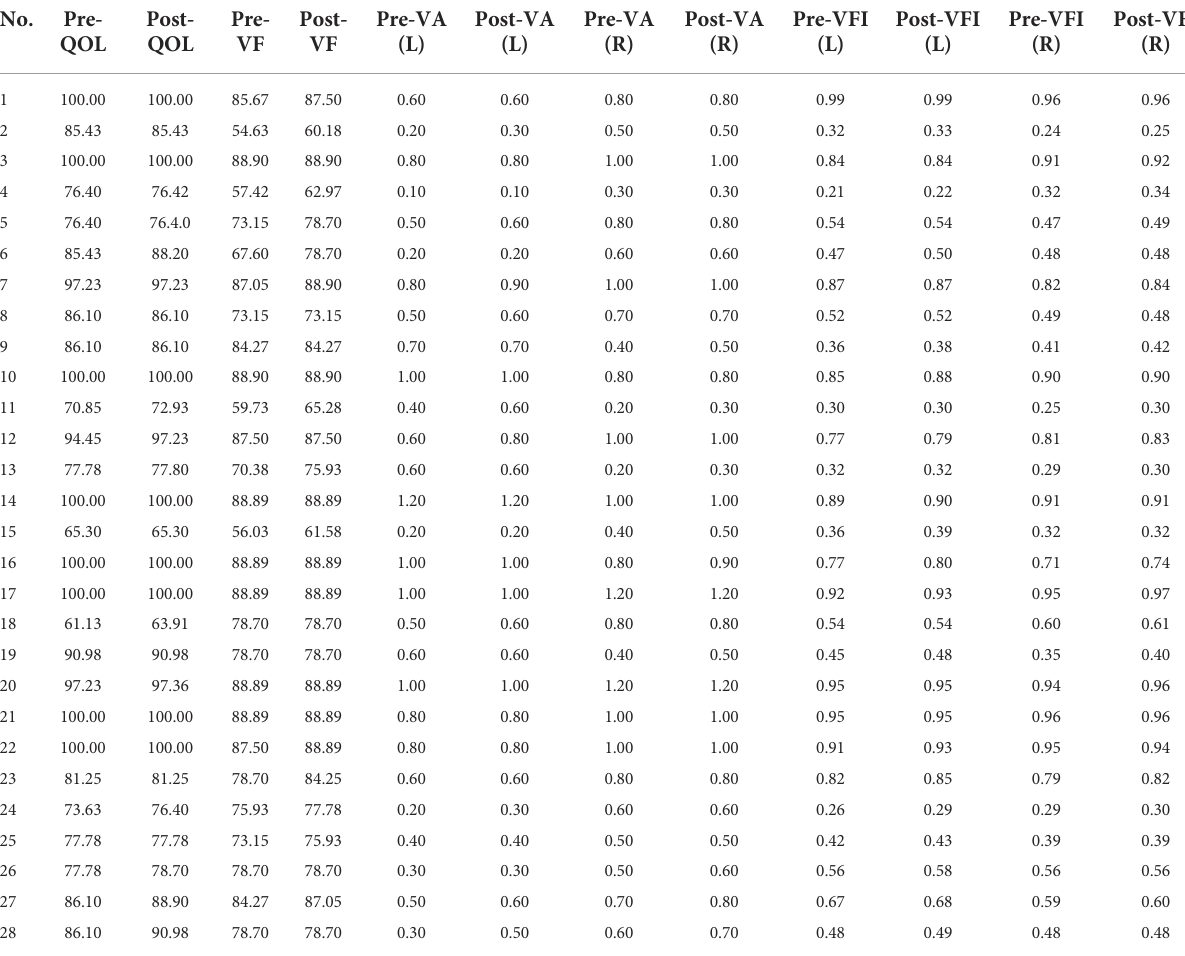
TABLE 2 The results of pre-operative visual exam and QOF compared to post-operative of 28 patients. No. Pre- QOL 100.00